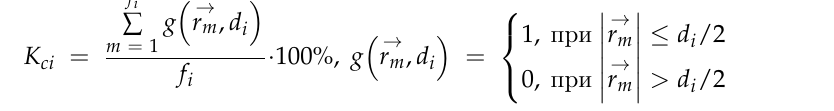
( e ) Figure 3. Stress–strain diagrams of the VT23 titanium alloy rolled in the transverse direction after the DNP and subsequent static tensioning, as compared to the static tensioning in the initial state (curve 1): ( a ) (2— ε і mp = 0.81%); ( b ) (3— ε і mp = 1.44%); ( c ) (4— ε і mp = 2.56%); ( d ) (5— ε і mp = 4.56%); ( e ) (6— ε і mp = 5.5%).